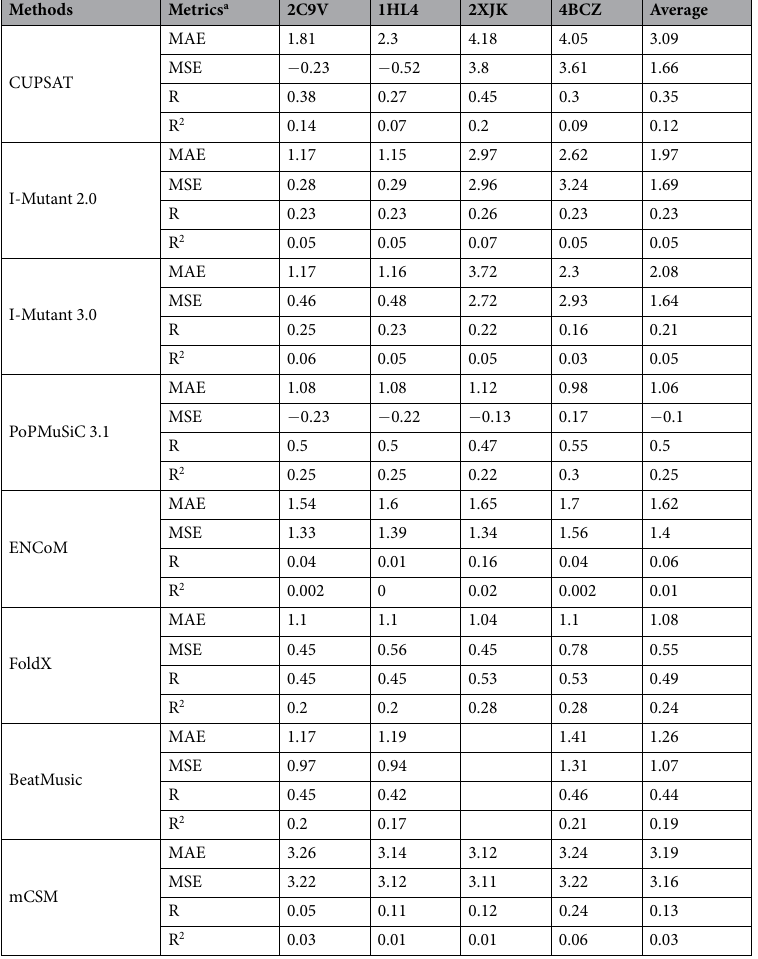
Table 1. Overall performance of stability predictors for 54 SOD1 monomer mutants using four different crystal structures. a MAE: Mean absolute error (kcal/mol). MSE: Mean signed error (experimental value minus computed value) in kcal/mol. R & R 2 = Correlation coefficient from regression